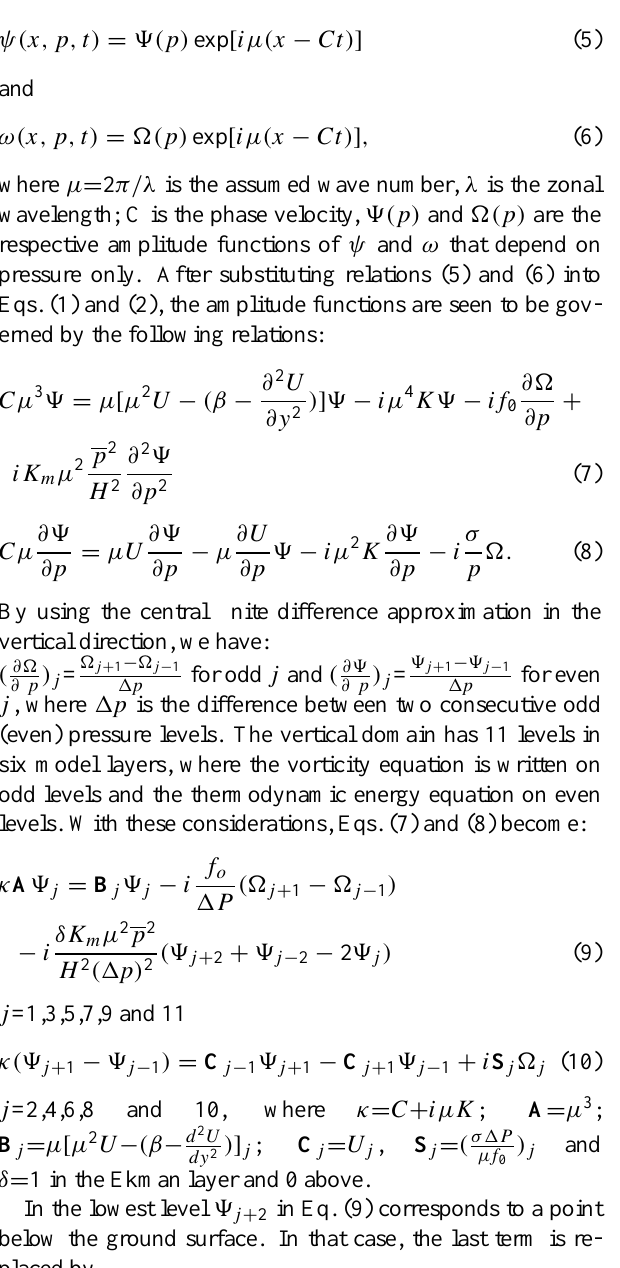
Table 1. The numerical values of the parameters (see text for defi-